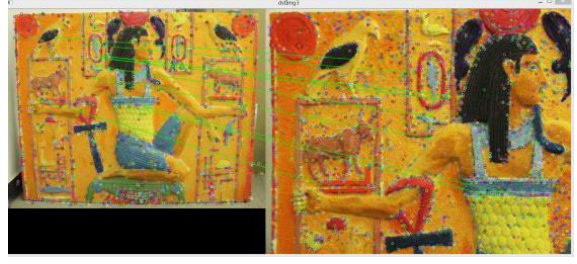
Figure 6. Local image matching